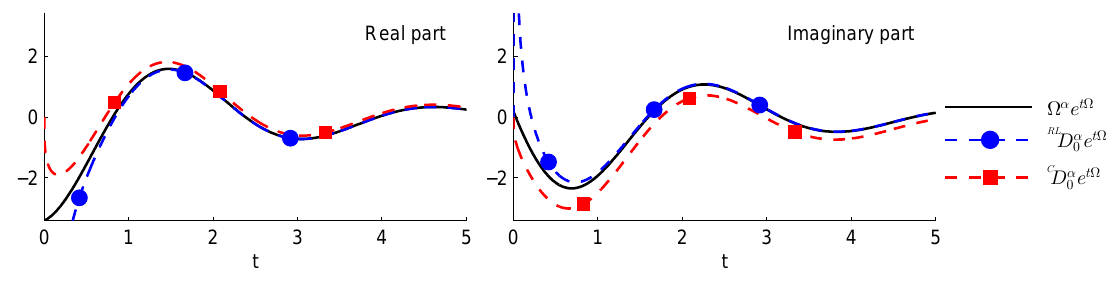
Figure 4. Comparison of RL D α